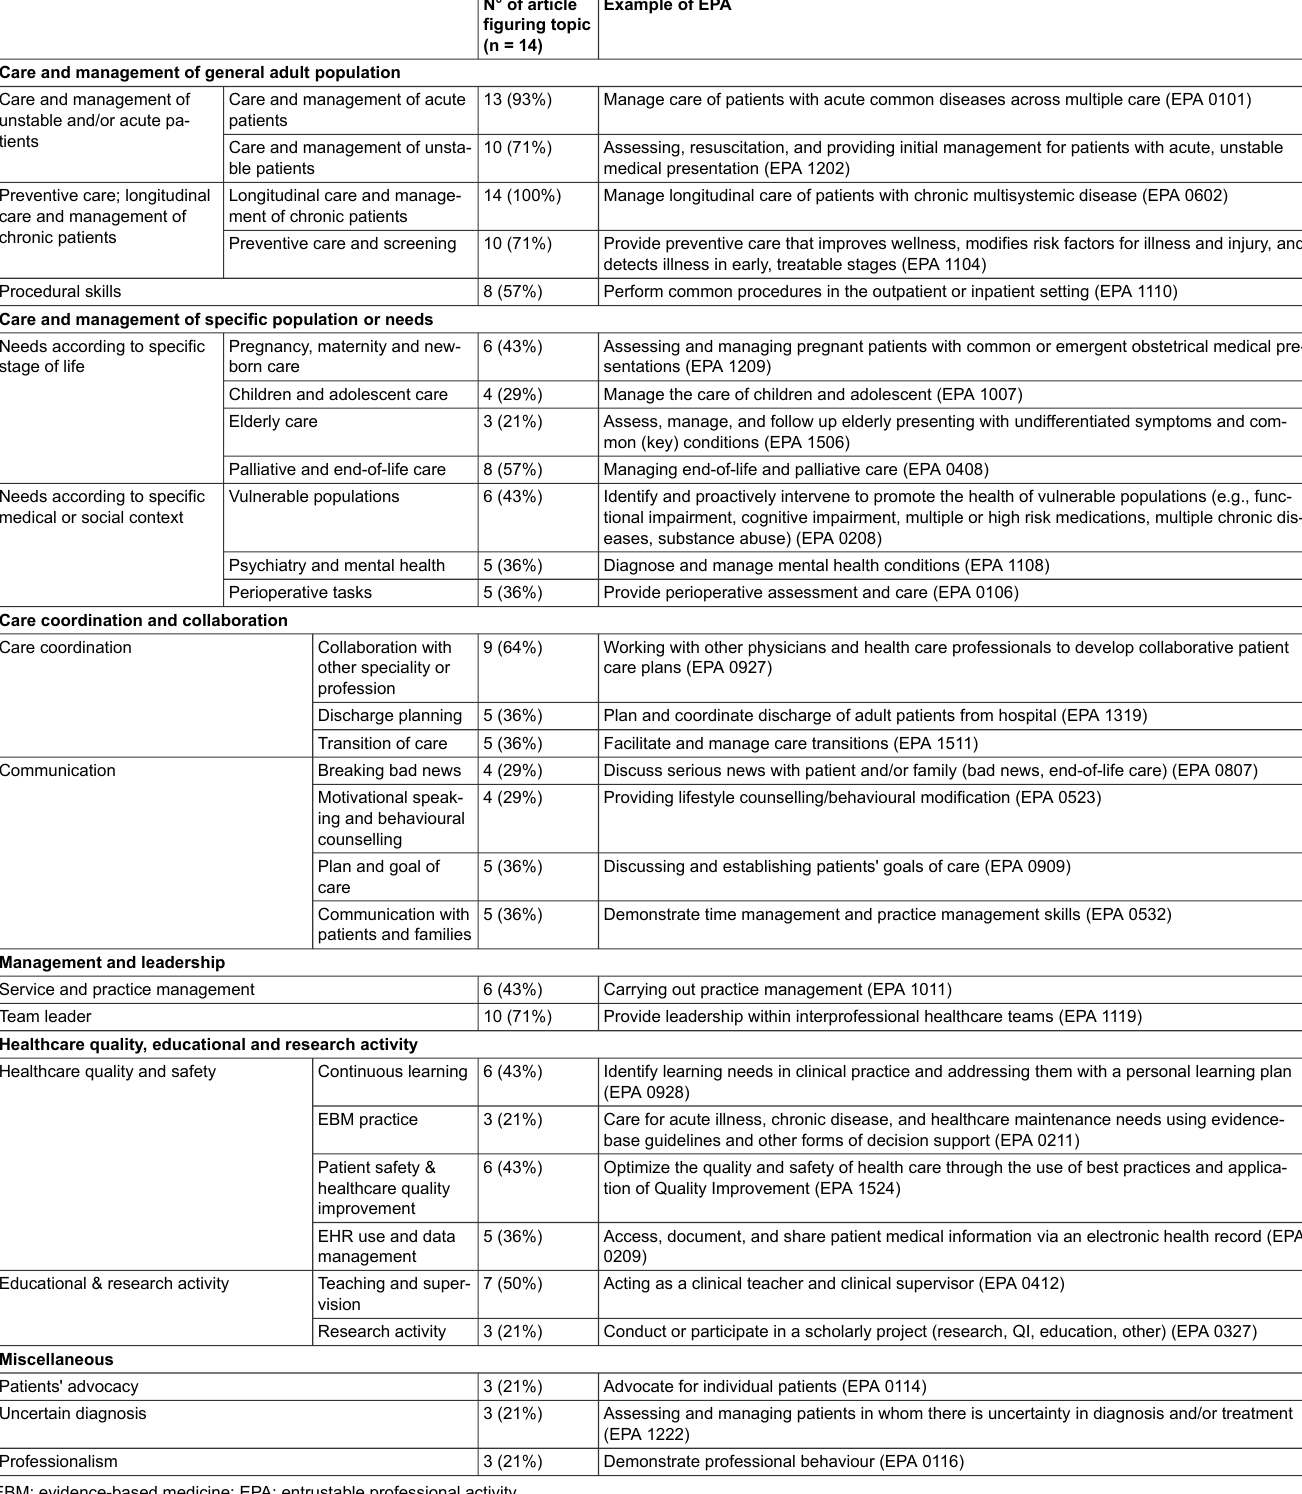
Table 2: Domains, themes, and subthemes and their representation among the selected articles.